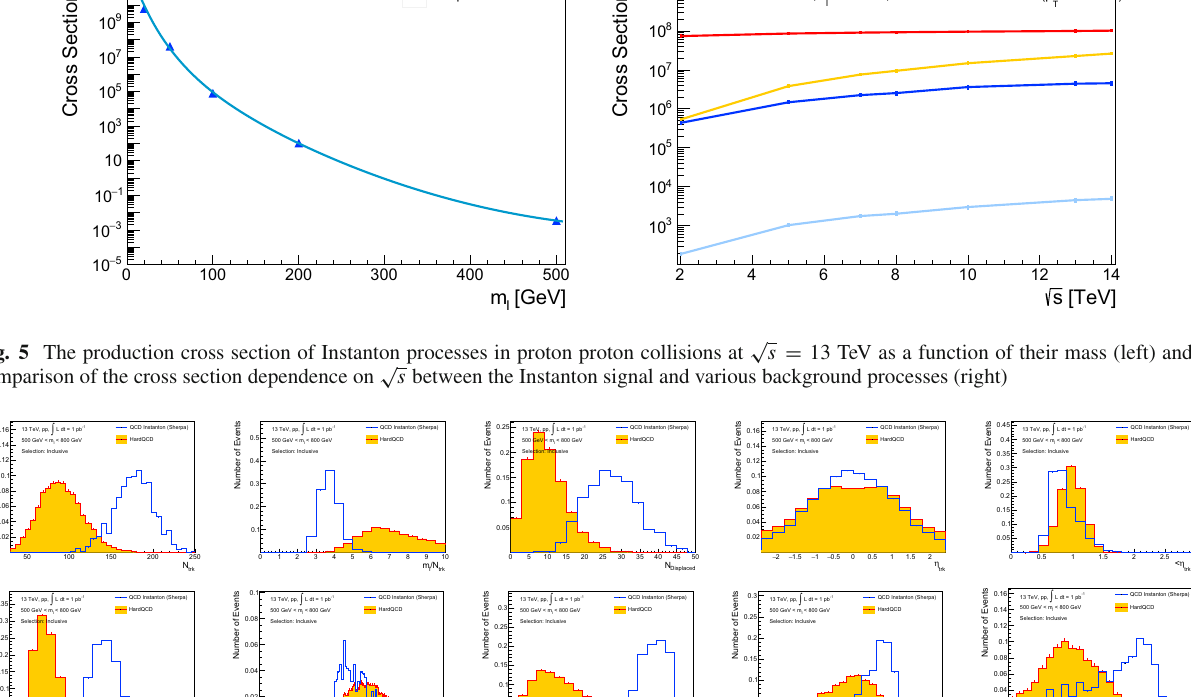
Fig. 6 Normalized distributions of the Instanton signal sample, generated by Sherpa with Instanton masses between 500 GeV and 800 GeV as well as for hardQCD processes in a similar mass range: N Trk , m I / N Trk , N Displaced , η Trk , (cid:7)| η Trk |(cid:8) , N Jets , S tracks angleisexpressedintermsofthepseudorapidity η